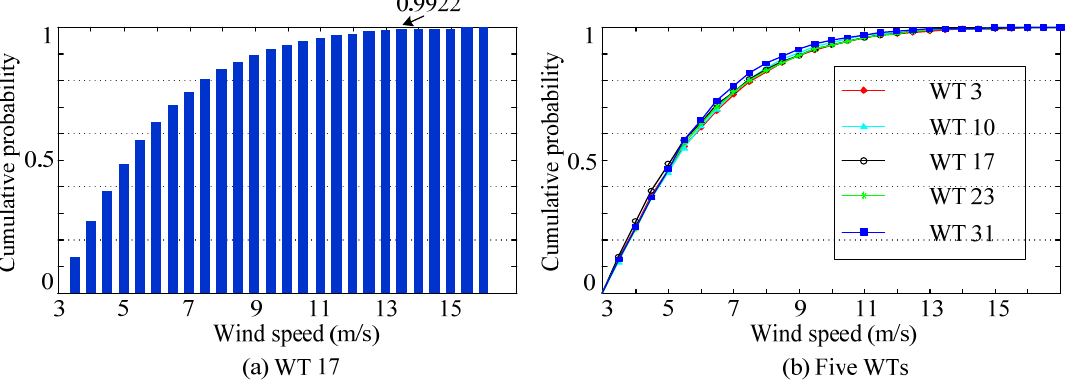
Figure 3. Wind speed probability distributions of WTs: ( a ) wind speed probability distributions of WT 17; ( b ) wind speed probability distributions of five